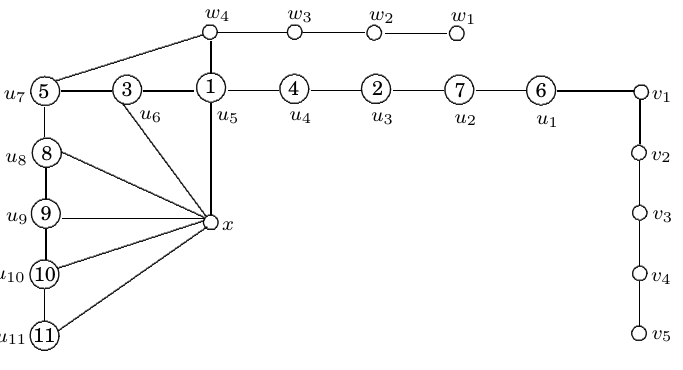
Figure 9: The graph G